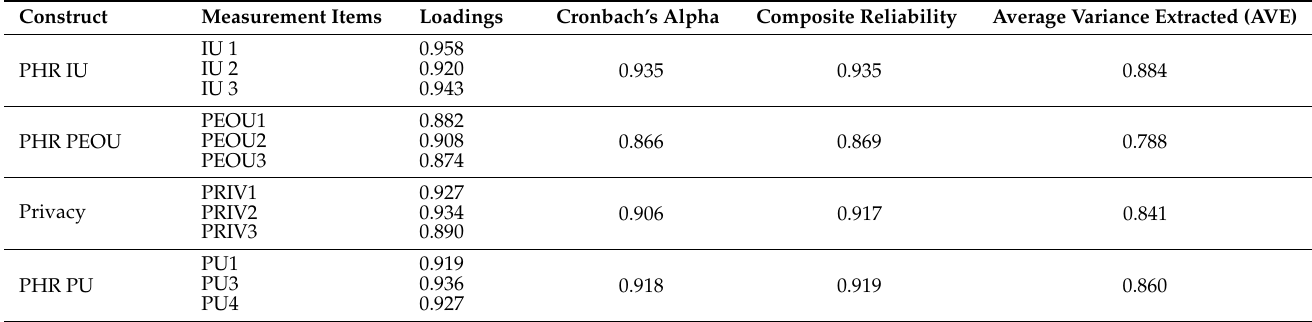
Table 2. Item loadings, Cronbach’s alpha values, composite reliability values, and AVE